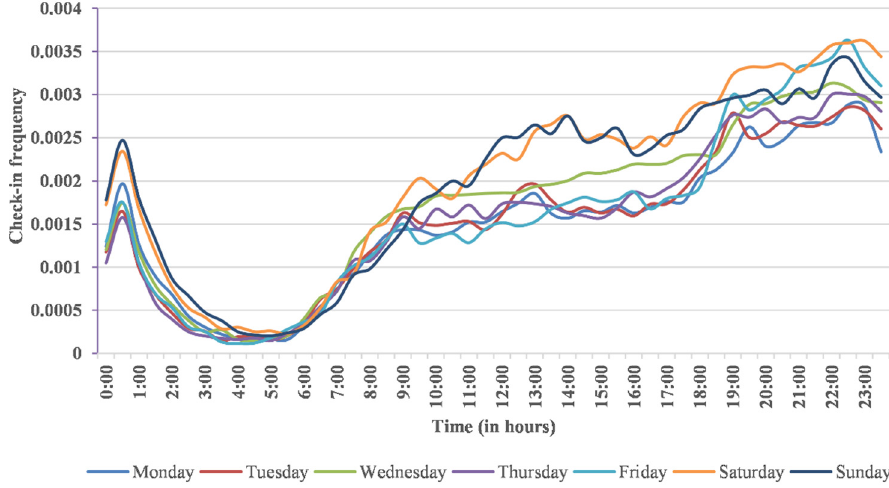
Figure 18. The check ‐ in frequency of females during the course of a week.